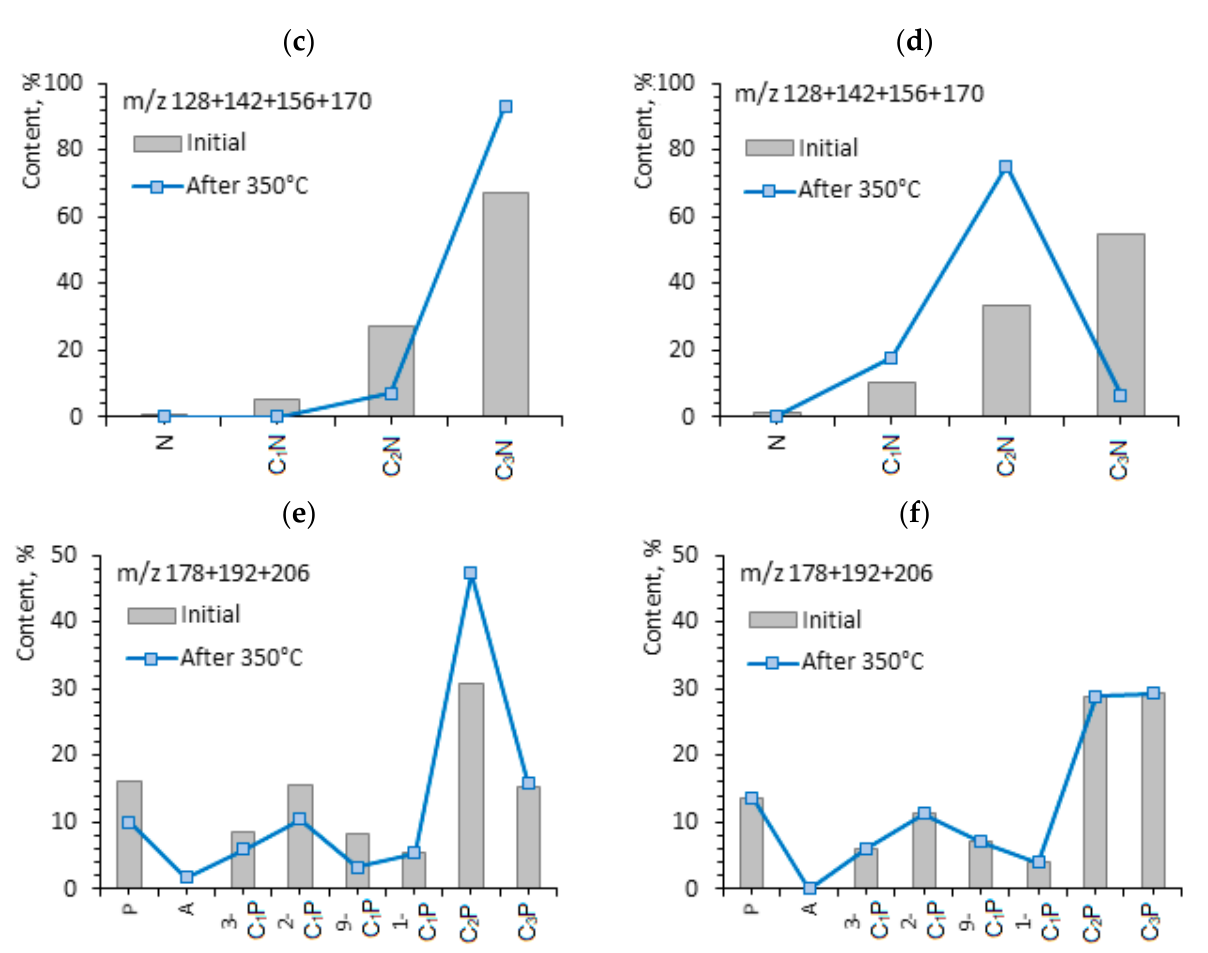
Figure 7. Diagrams of the molecular weight distribution of ( a , b ) arylisoprenoids, ( c , d ) naphthalenes, and ( e , f ) phenanthrenes before and after hydrothermal experiments at 350 °C.